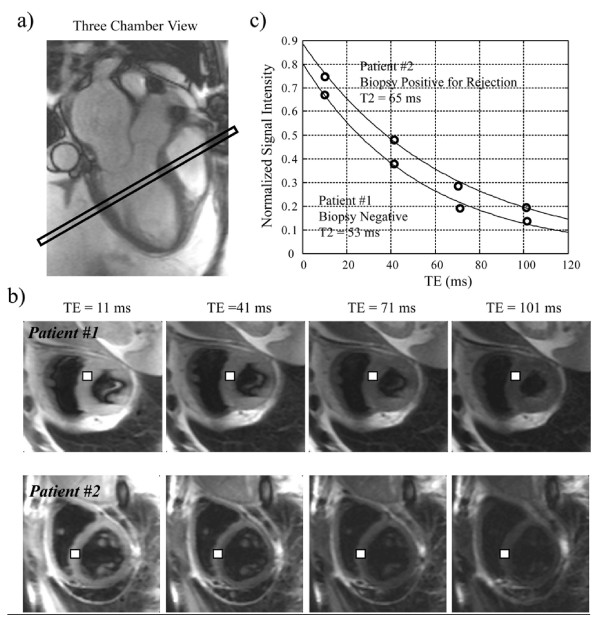
Comparison of T2 in 2 cardiac transplant patients. a) Localizing 3 chamber FISP image. b) Axial HASTE images with varying echo times (TE). White square represents septal ROI used to measure signal intensity (SI). c) Plot of SI vs. TE. T2 derived from fitting to curve to an exponential. Patient 1: CMR T2 = 53 ms (normal). Biopsy = no rejection. Patient 2: CMR T2 = 65 ms (elevated). Biopsy = ISHLT grade 2R rejection.